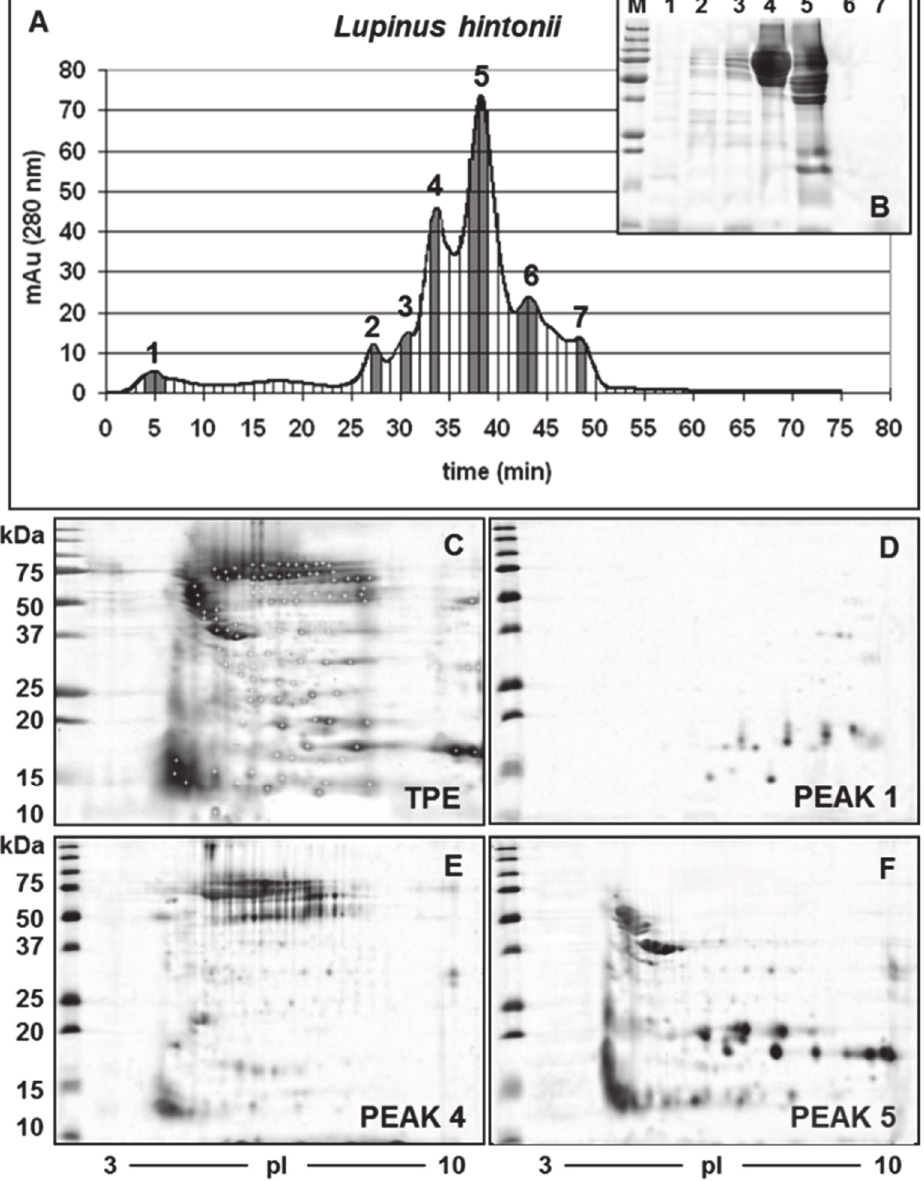
Figure 1. Electrophoretic gels of proteins of L. hintonii . ( A ) HPLC chromatogram of the total protein extract (TPE) on a MonoQ column. ( B ) SDS-PAGE of preparative HPLC collected fractions. ( C ) Proteome reference map of reduced TPE (proteins were run in the first dimension on 7-cm, pH 3–10 non-linear IPG strips; in the second dimension on 13% denaturing SDS–PAGE gel), where in total 116 spots were detected. ( D ) Two-dimensional map of purified γ -conglutin. ( E ) Two-dimensional map of purified β -conglutin. ( F ) Two-dimensional map of purified α -conglutin. The standard marker (Precision Plus Protein) is indicated in kDa on the left.